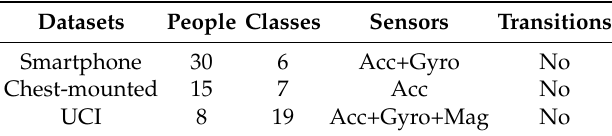
Table 9. Basic information of the three public datasets.